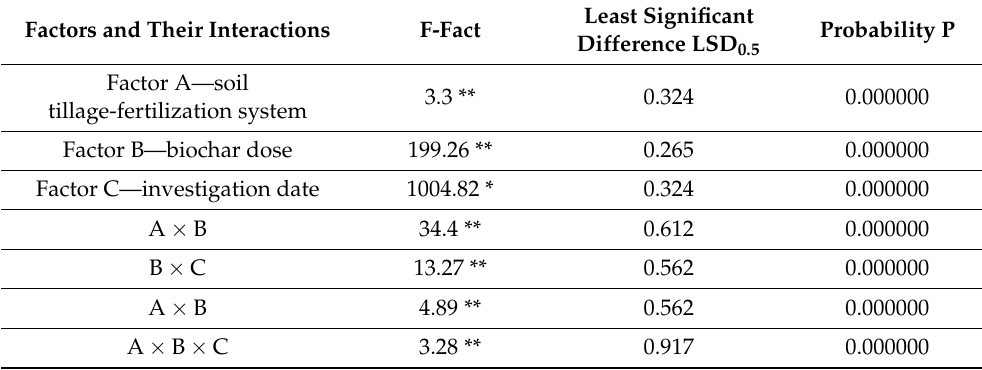
Figure 9. Influence of biochar on changes of soil water holding capacity in different tillage-fertilization systems (S—shallow no-till tillage, M—direct sowing, 1—unfertilized, 2—fertilized) after 3, 6, 12, and 24 months from the beginning of the experiment, n = 2. Table 5. Variance analysis of soil water holding capacity, n =